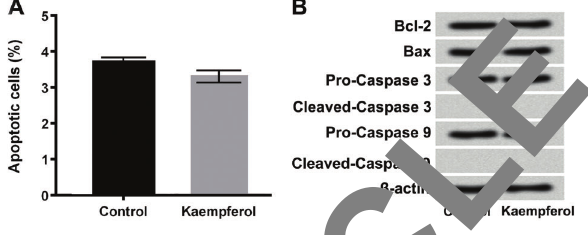
Figure 3. Kaempferol had no in fl uence on SNU-216 cell apoptosis. A , Annexin V-FITC/PI staining was used to assess the apoptosis of SNU-216 cells after 50 m M kaempferol treatment. B , Western blotting was performed to detect the expressions of Bcl-2, Bax, pro-caspase 3, cleaved-caspase 3, pro-caspase 9, and cleaved-caspase 9 in SNU-216 cells after 50 m M kaempferol treatment. Data are reported as means ± SD ( t